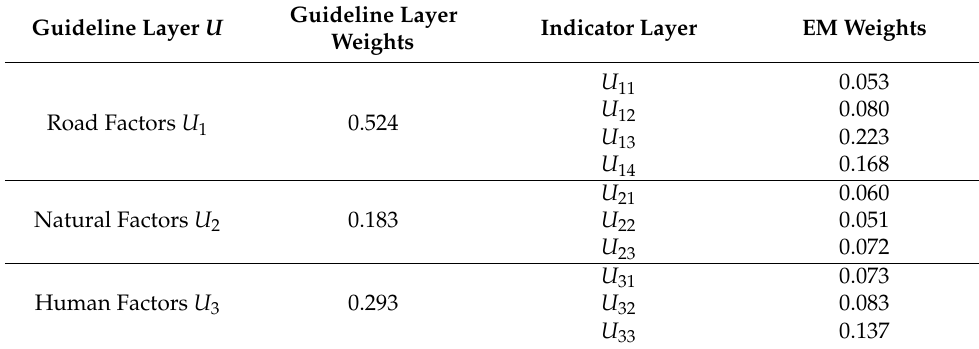
Table 10. The weighting of road traffic trend indicators for the EM method.